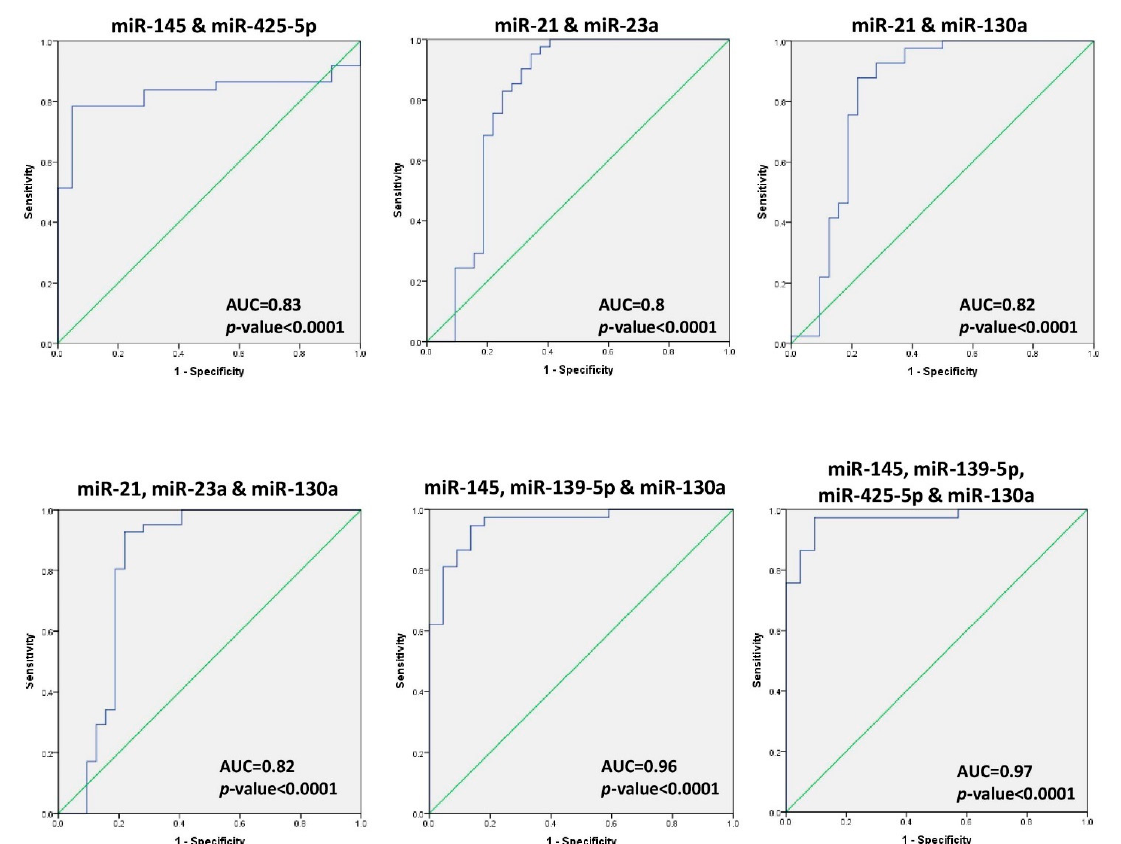
Figure 4. Diagnostic accuracy of combined miRNA for BC detection in plasma. Predicted probabilities were calculated using binary logistic regression to draw the ROC curve of the combined miRNAs. The ROC curve analysis separates BC patients and healthy controls through combinations of miRNAs. p < 0.05 indicates significance.